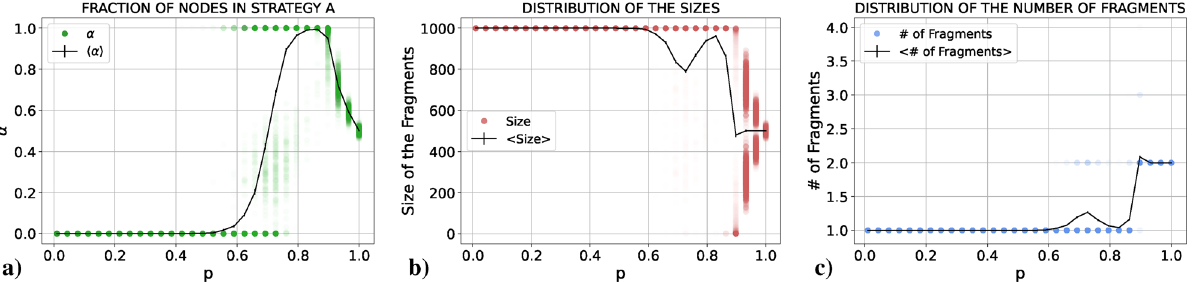
Figure 6. Results for ( a ) α , ( b ) the size and ( c ) the number of fragments (single realizations in green, red and blue, respectively, and average values in black) as a function of p for a GCG with coevolution played in an E–R network with � k � = 30 using the UI update rule, with ( S , T ) = ( − 1.35, 0 ) The second one is the line that separates the region in which the system coordinates on action A (green) from the region in which the system coordinates on action B (yellow). This is the line we can refer to green-yellow transition line. In this specific Figure, both lines are coincident and this is how we know that the system always coordinate on the risk-dominant action. Our hypothesis is that coevolution displaces the second line towards the region in which action B is the risk-dominant action (the first line is theoretical, it does not change). A displace- ment of the second line towards the region in which action B is the risk-dominant while the first line remains in the same place would imply that there is an intermediate region in which the system coordinates on action A for values of ( S , T ) for which action A is not the risk-dominant action anymore. This is going to become clear in the next two sections.